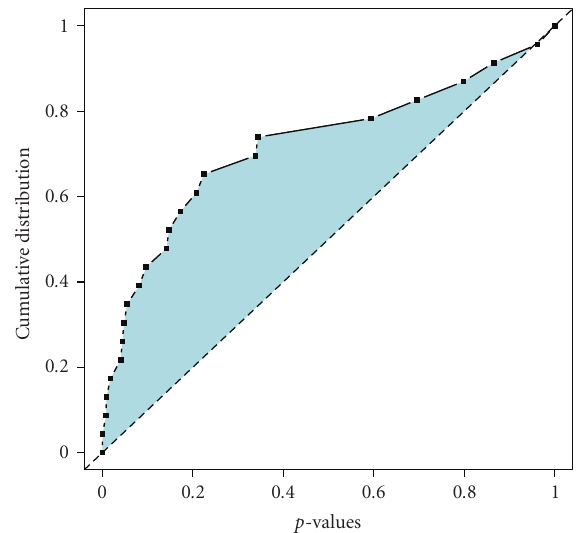
Figure 5: This figure shows the quantile-quantile plot for D LM-Left . Depicted are the individual P -values for a Wilcoxon-Mann- Whitney test of each HR subject, in turn, based on the two samples { d (HR,CTRL } and { d (HR,MDD } i ) i )